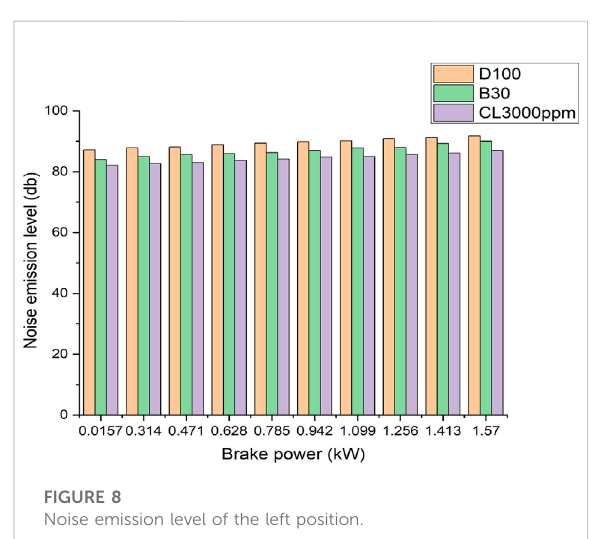
oil as an antioxidant. Copper (Cu) wear in engine oil samples is one of the most serious issues for biodiesel engines, as shown in Figure 7B. The concentration could be obtained because of the wear of the bearings, bronze, and bushings. Figure 7B shows the copper concentration in engine oil samples. It was lower in biodiesel and clove blended than in diesel fuel. Figure 7C shows that the source of nickel (NI) bearing piston nickel concentration is higher in diesel fuel than in biodiesel-mixed fuel. Figure 7D depicts bushes,